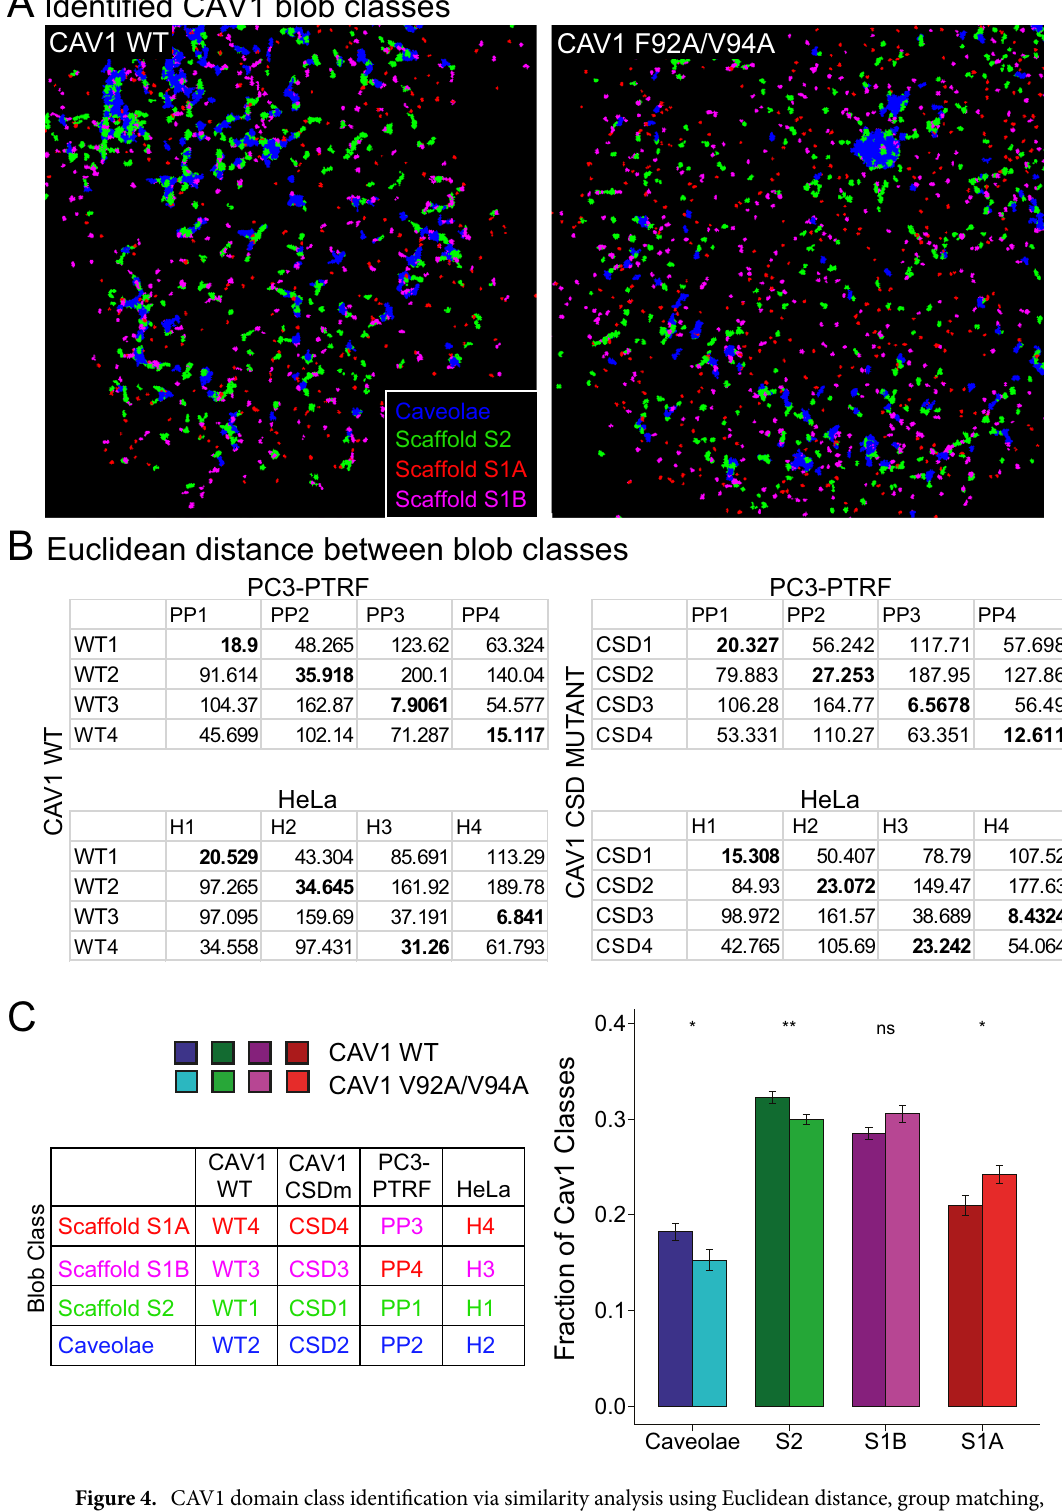
Figure 4. CAV1 domain class identification via similarity analysis using Euclidean distance, group matching, and fraction of CAV1 domains. ( A ) Representative images processed with blob identification by machine learning using 3D SMLM Network Analysis. ( B ) Euclidean distance between blobs’ average features of the different classes of CAV1 WT (WT1-4) and CSD (CSD1-4) mutant to PTRF-expressing PC3 (PP1-4) and HeLa (H1-4) cells 8,10 . Bolded values correspond with ( C ) Identifying caveolae and S2, S1B and S1A scaffold blob groups from the shortest Euclidian distances. The classes are color coded based on the matched CAV1 domains across CAV1 WT, CSD, and the previously studied PC3-PTRF and HeLa SMLM data. Proportion of blob classes between CAV1 WT and CSD mutant (two-tailed unpaired t test; * p < 0.05; ** p <